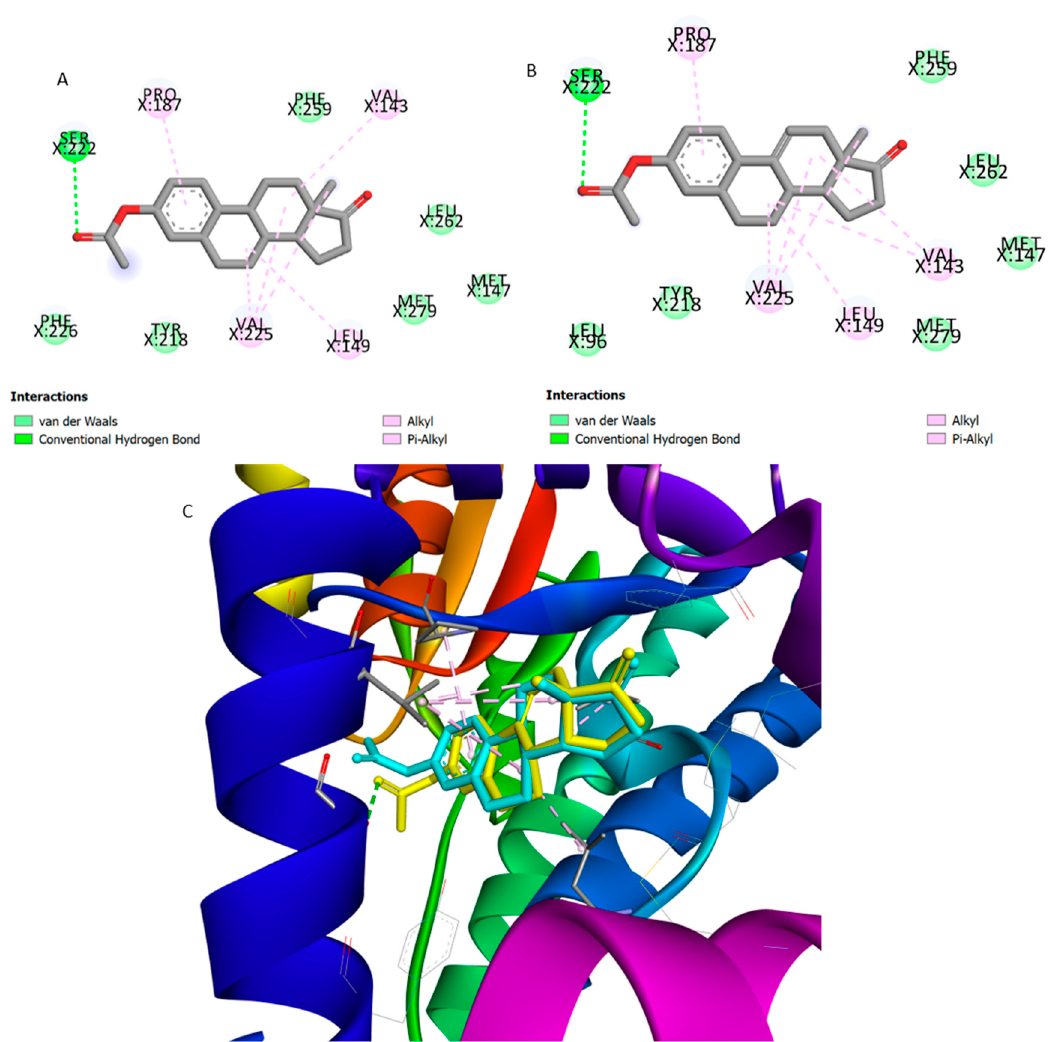
Figure 9. Predicted interactions of the best ranked and synthetized compounds 2 and 6 , with 17 β -HSD1 in 2D (panel A and B) and 3D (panel B). ( A ) Van der Waals interactions are displayed in light green, conventional hydrogen bonds in green, and alkyl and pi-alkyl in pink. Both compounds, as co-crystalized ligand DHT, present alkyl and pi-alkyl interactions with Pro187, Val143, and Leu149. ( B ) Van der Waals interactions are displayed in light green, conventional hydrogen bonds in green, and alkyl and pi-alkyl in pink. ( C ) 3D representation of overlapping of compound 2 (in turquoise) and 6 (in yellow) in the macromolecule binding pocket.